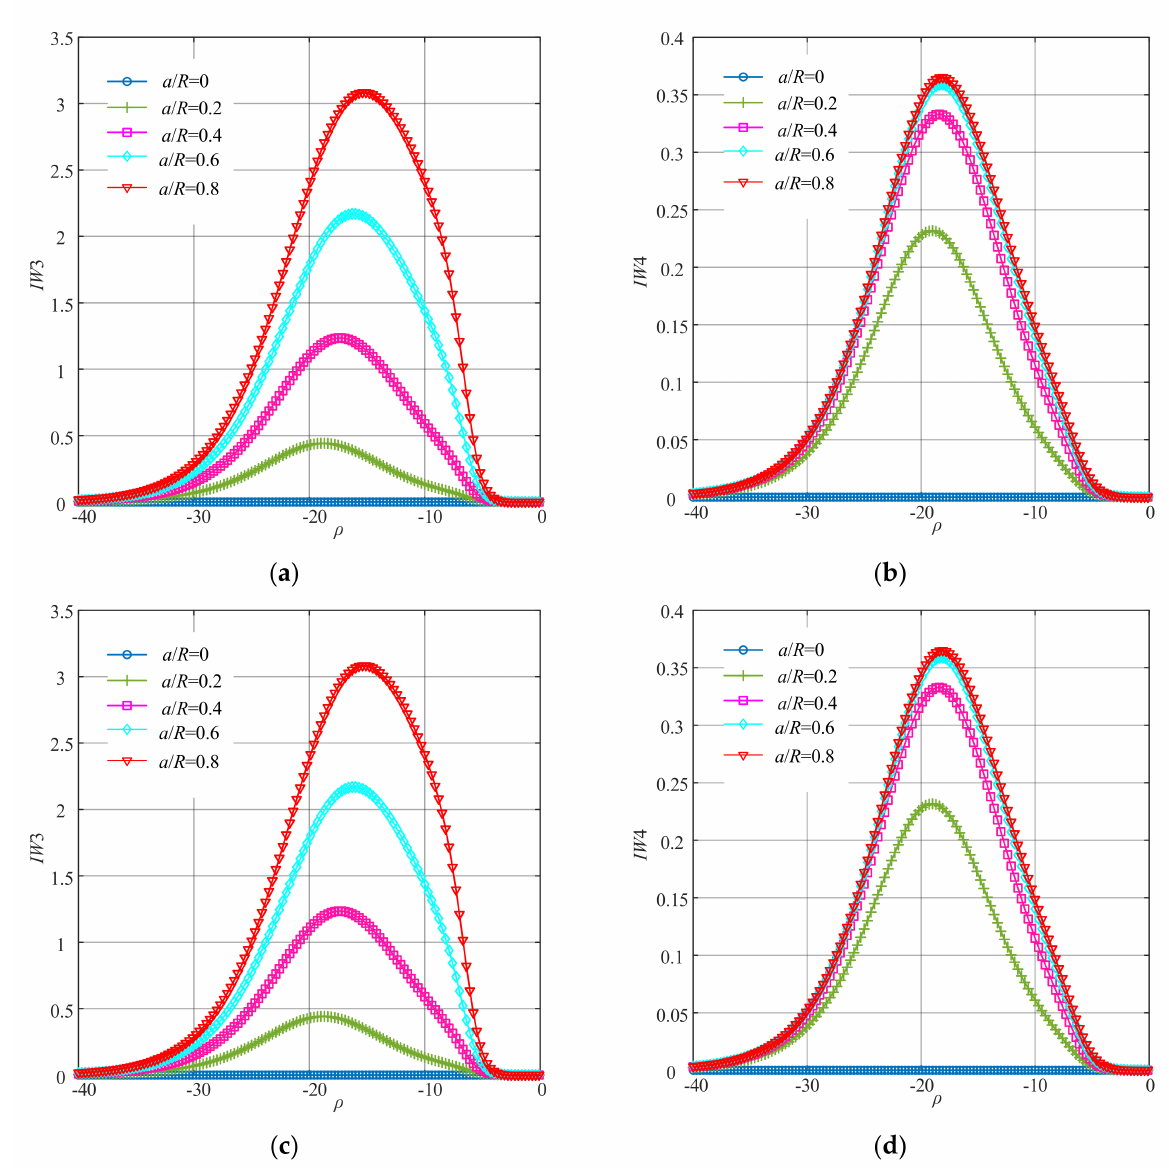
Figure 5. The curves of each order of improved WNOFRFs under different crack faults: ( a ) IW 1, ( b ) IW 2, ( c ) IW 3 and ( d ) IW